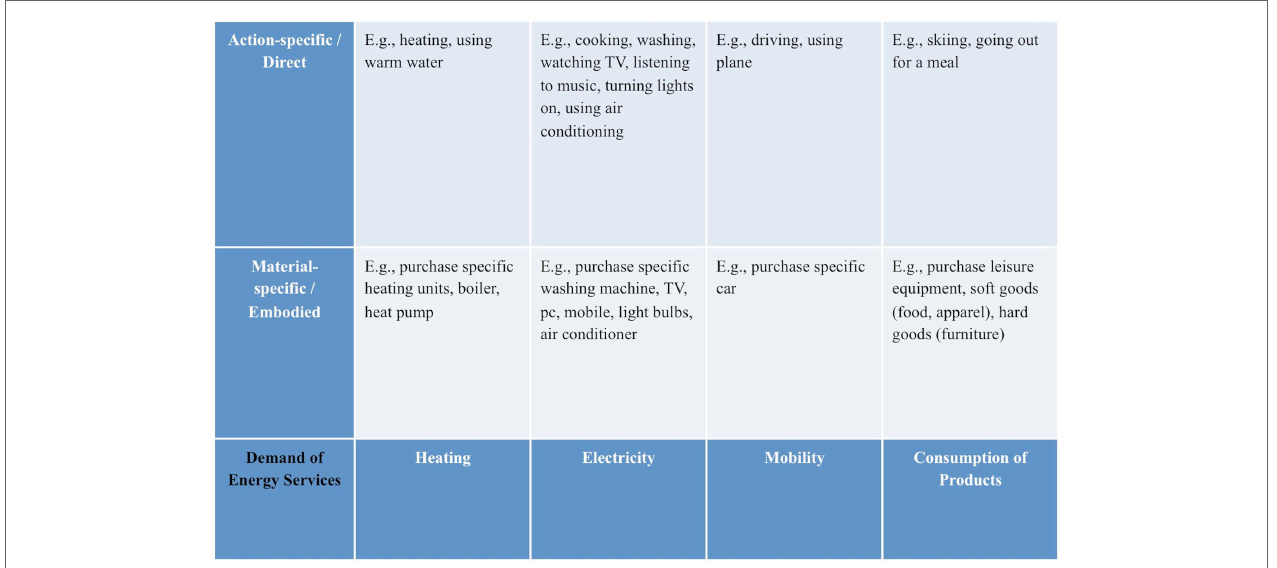
FiGUre 1 | explananda – examples for types of eCB